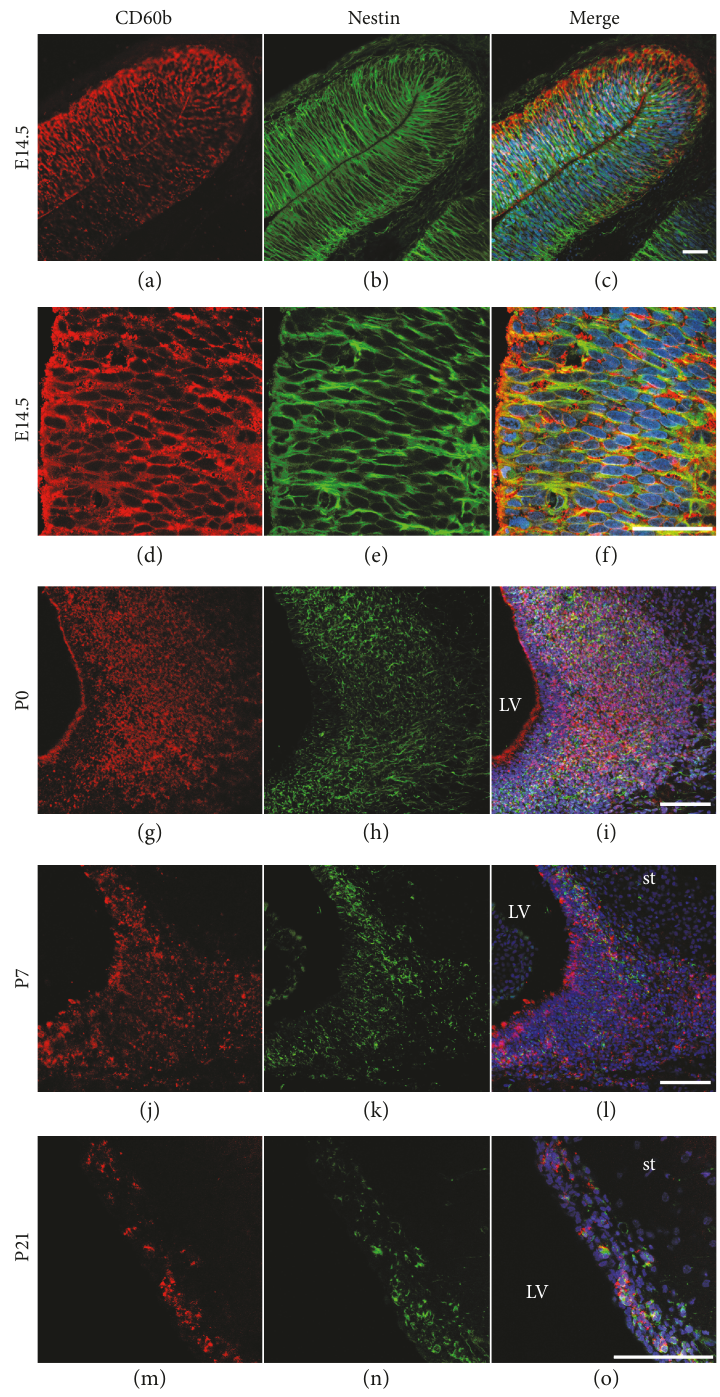
Figure 1: CD60b expression decreases throughout cortical development. Confocal photomicrographs showing the expression of 9-O-acetyl GD3 (CD60b in red) and nestin (in green) in the developing cerebral cortex of E14.5 (a – f), P0 (g – i), P7 (j – l), and P21 (m – o) rats. In E14.5, CD60b is expressed in cell bodies and radially oriented structures (a – c) and its distribution is very similar to nestin distribution (d – f). From P0 to P21, there is a progressive decrease in CD60b expression, but its distribution is still similar to nestin distribution. Nuclei were stained with TO-PRO-3 (blue). Scale bars: 50 μ m (a – f) and 100 μ m (g – o). st: striatum; LV: lateral